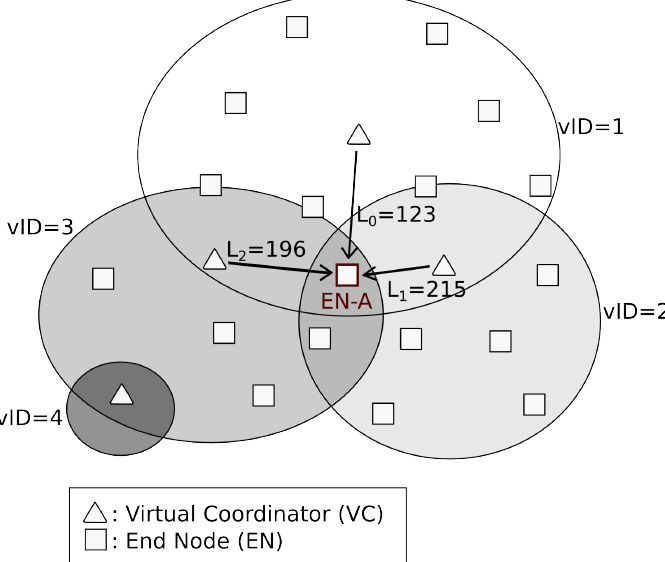
Figure 3. Example of node collecting LQIs for the link selection and role adoption